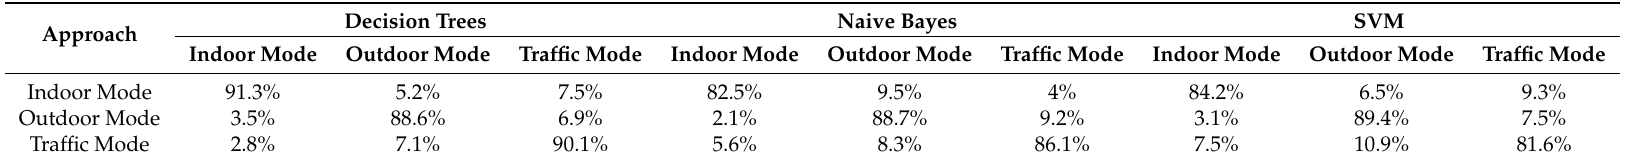
Table 2. Moving mode detection